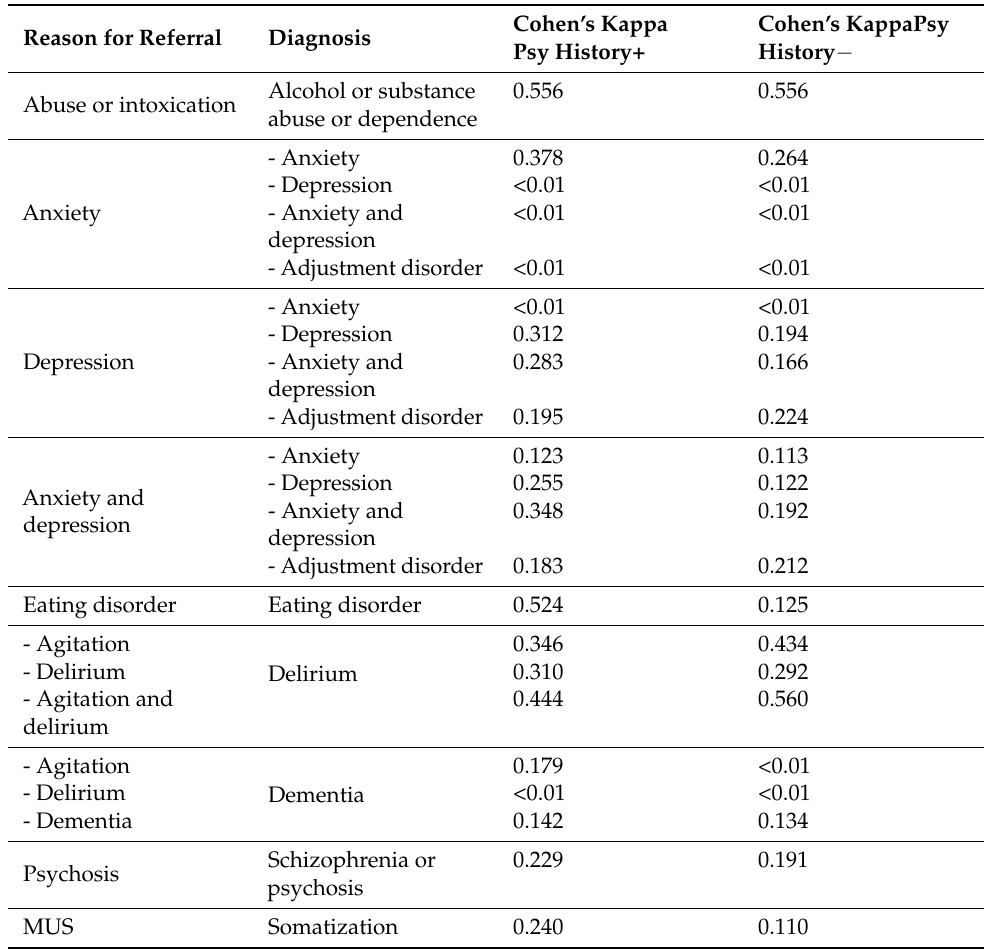
Table 5. Comparison of inter-rater agreement: Positive psychiatric history vs. negative psychi- atric history.